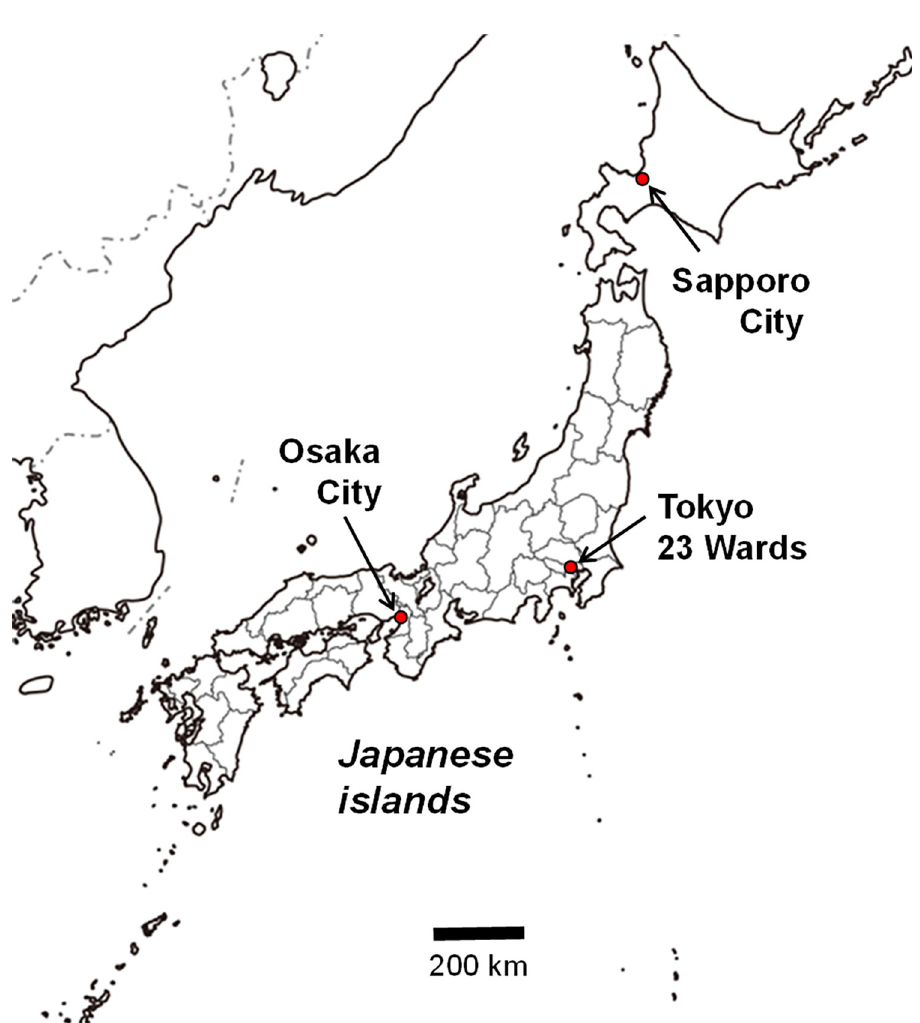
Fig 1. Locations of Sapporo City, Tokyo 23 wards, and Osaka City in Japan. The map is provided from https://www. freemap.jp/ licensed under CC BY 4.0.